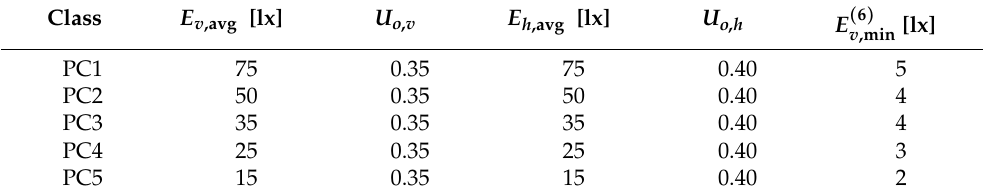
Table 2. PC-lighting classes for pedestrian crossings, according to the Polish standard